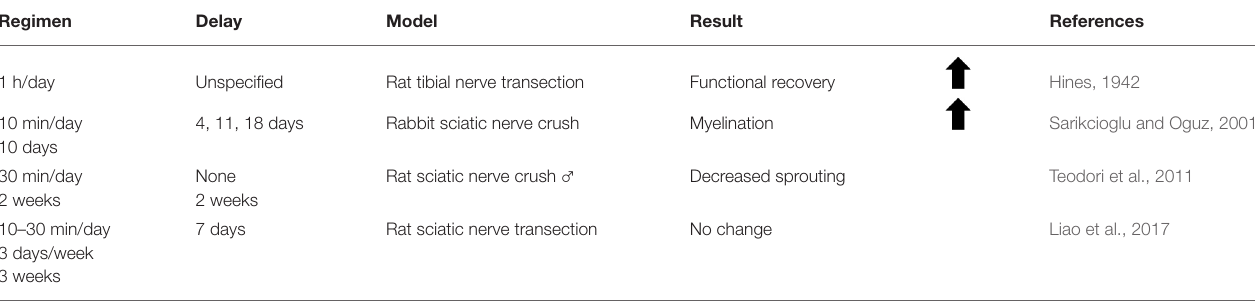
TABLE 3 | Effect of swimming exercise on peripheral nerve